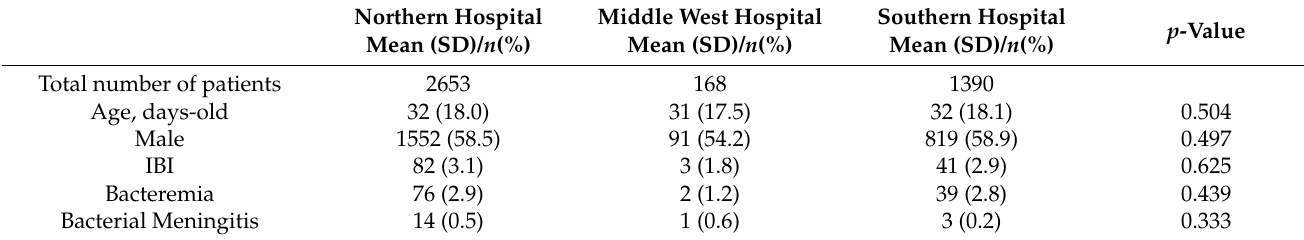
Table 2. Distribution and demographics of patients in three examined hospitals.